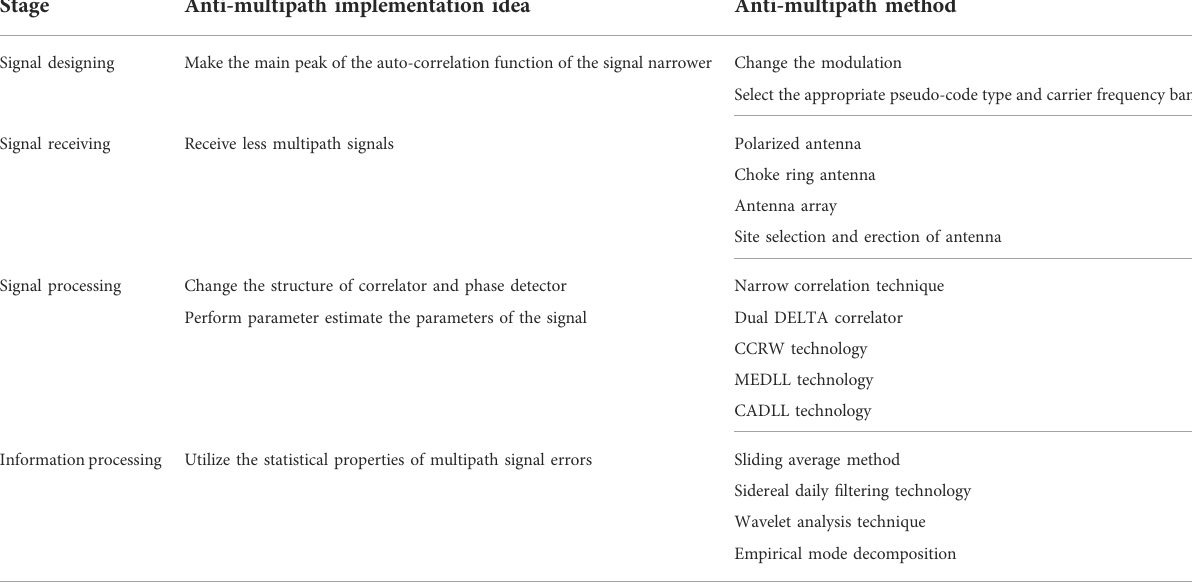
TABLE 2 Summary of multipath mitigation techniques in each stage of signal processing. Stage Anti-multipath implementation